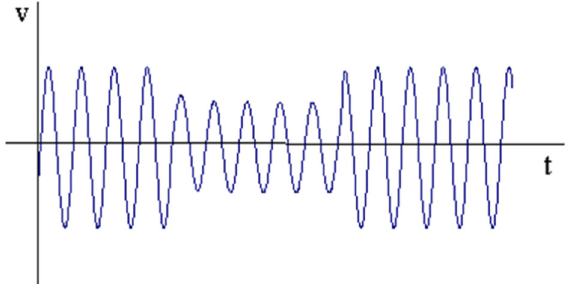
Fig. 1 Voltage waveform during Sag